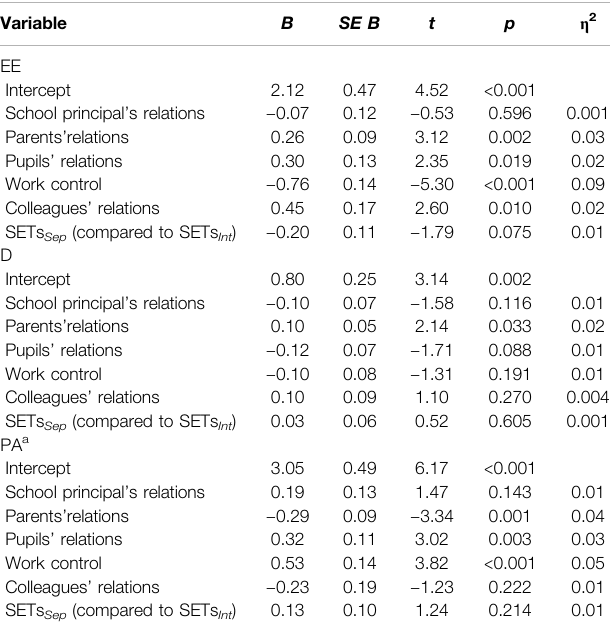
TABLE 12 | Multiple regression analyses to predict the three dimensions of burnout by all collaboration-related variables, controlling for subgroup membership.